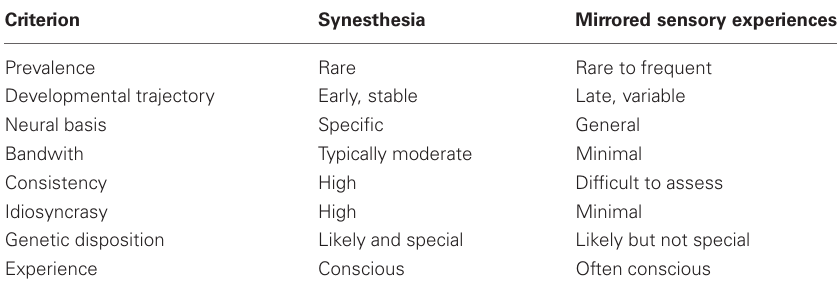
Table 1 | Commonalities and differences between synesthesia and mirrored sensory